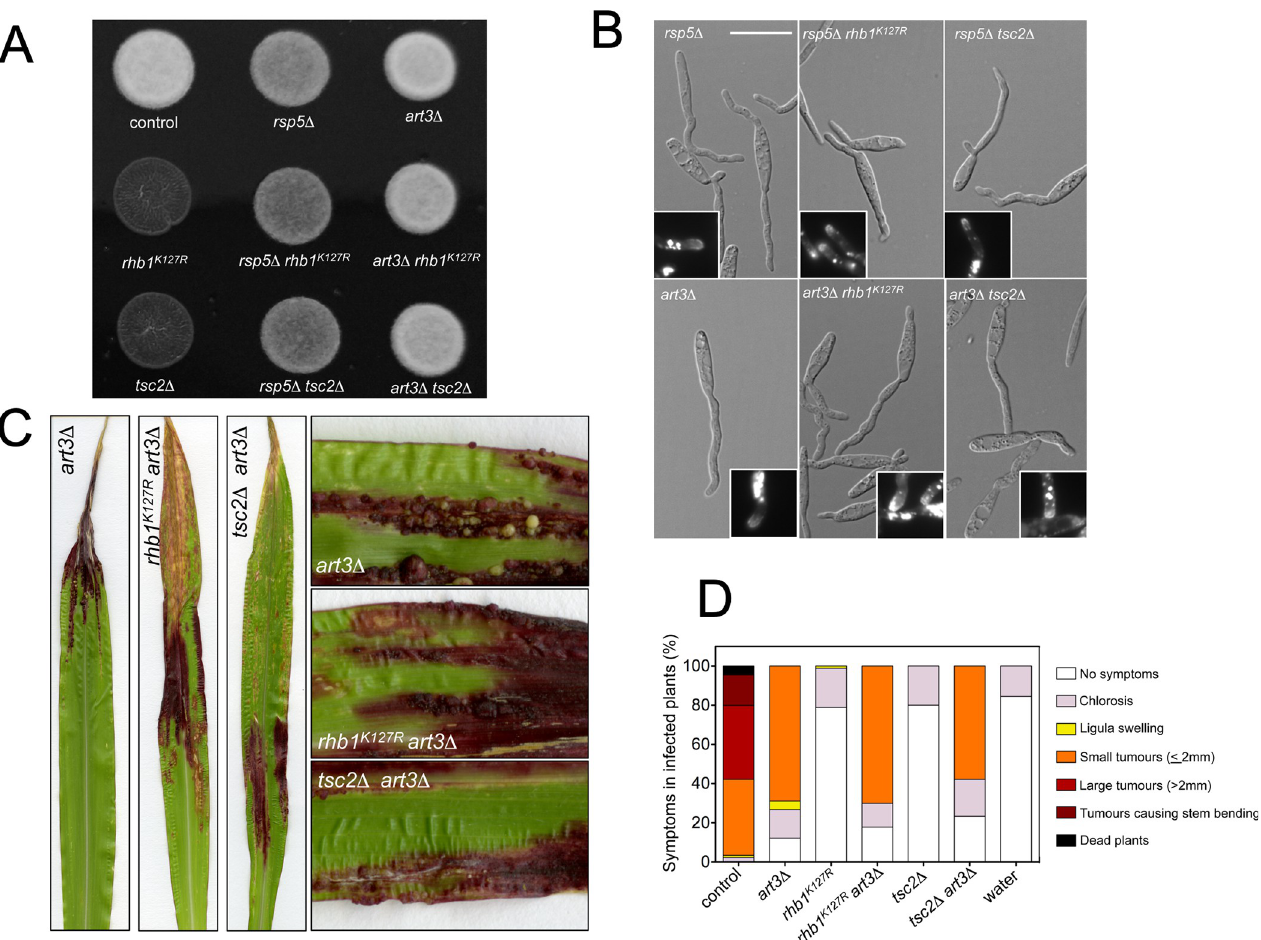
Fig 9. The inhibition of the pheromone response by unscheduled activation of Rheb requires Rsp5 and Art3. (A) Strains carrying the Rheb-activating alleles and loss-of-function mutations in rsp5 or art3 were able to form infective filaments. Crosses of control (FB1xFB2) and the indicated mutant strain combinations were spotted on minimal ammonium media charcoal plates and incubated for 24 h at 28˚C. The white fuzzy colonies reflect the formation of b - dependent filaments. (B) Strains carrying the Rheb-activating alleles and loss-of-function mutations in rsp5 or art3 were able to form conjugation tubes and polarize Pra1-GFP. Fluorescent cell images from cultures of the indicated strains carrying an endogenous pra1-GFP allele incubated for 6 hours in minimal ammonium media in the presence of synthetic a2 pheromone (2.5 μ g/ml). Cell images were obtained with the same time exposure. Insets showed magnification of selected cell tips. Bar: 15 μ m. (See S19 Fig for wide-field images). (C) Strains carrying the Rheb-activating alleles and loss-of-function mutations in art3 were able to infect plants. Representative leaves 14 days after infection with the indicated strains is shown. (D) Graph showing disease symptoms caused by crosses of wild-type (control) and the indicated mutant strains. The symptoms were scored 14 days after infection. Three independent experiments were carried out, and the average values are expressed as a percentage of the total number of infected plants (n: 30 plants in each experiment).